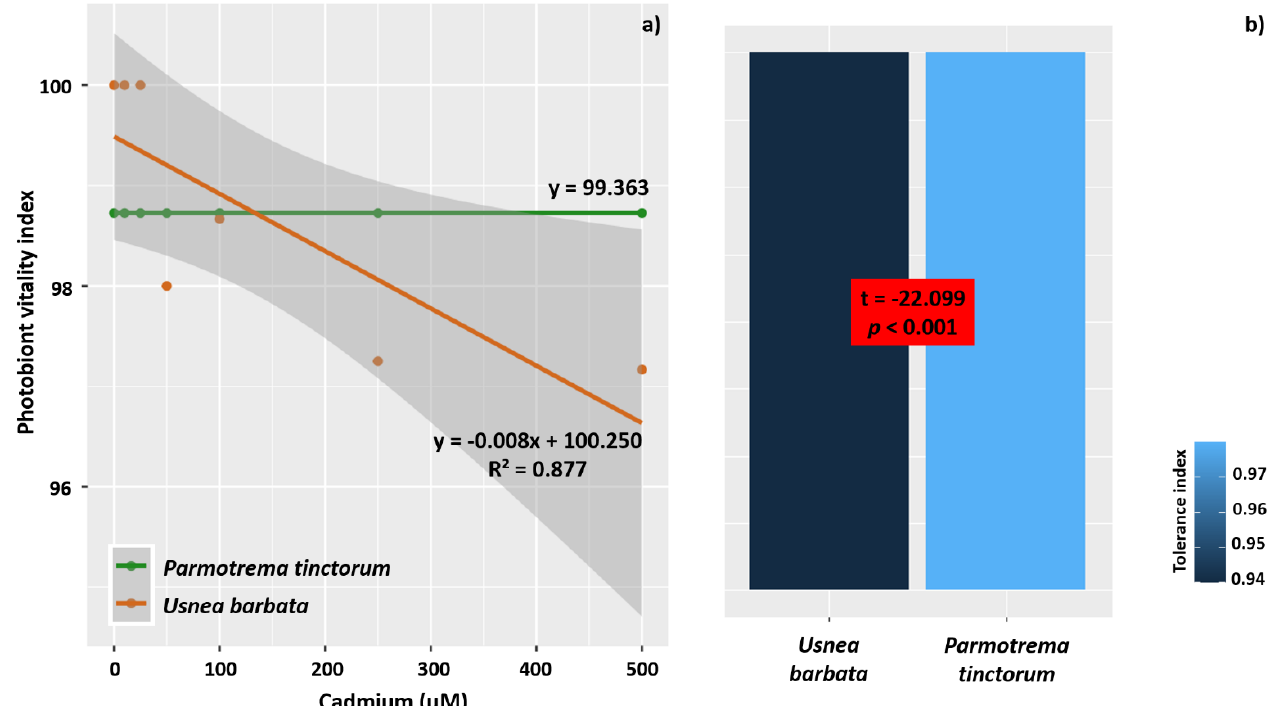
Figure 12. Photobiont vitality index (PVI) ( a ) and tolerance index ( b ) to high cadmium concentrations (500 µM) observed for the thalli of the lichen species Parmotrema tinctorum and Usnea barbata subjected to the action of Cd. Differences analyzed by Student ’ s t -test at a 0.05% significance level.